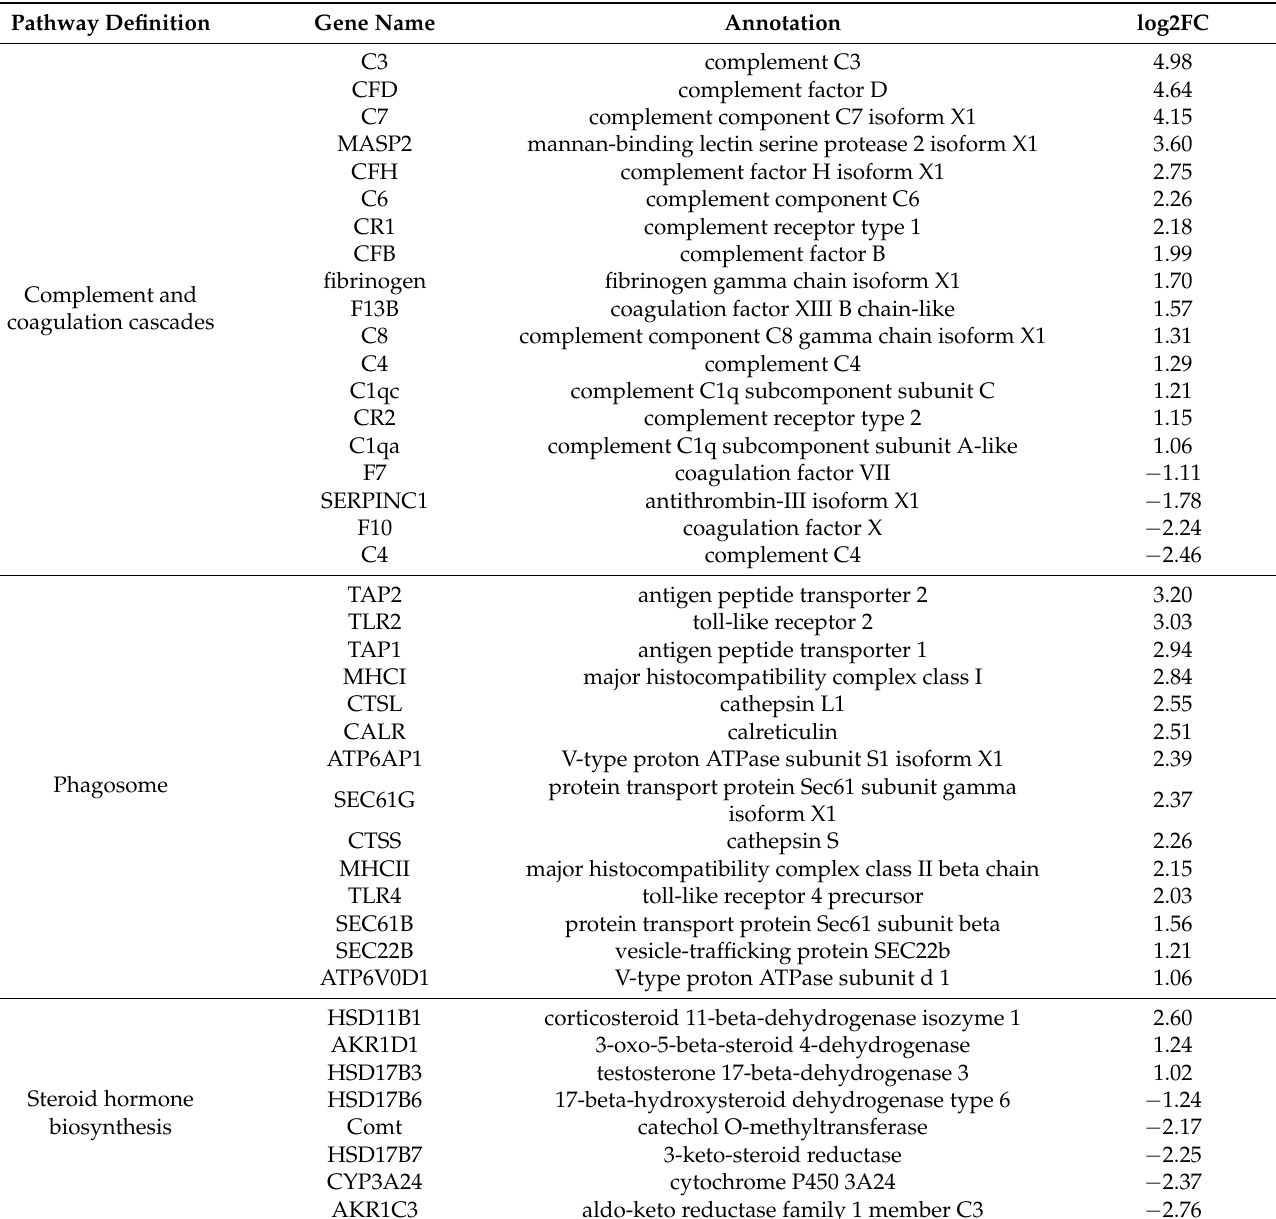
Table 3. The representative differentially expression genes involved in the key